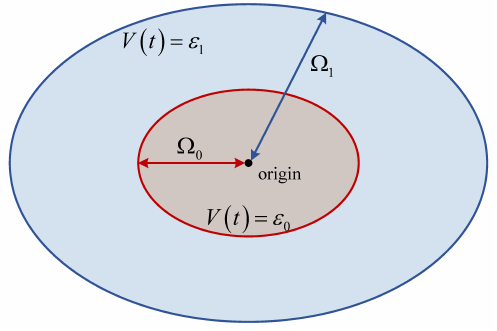
Figure 6. Boundary of the observation